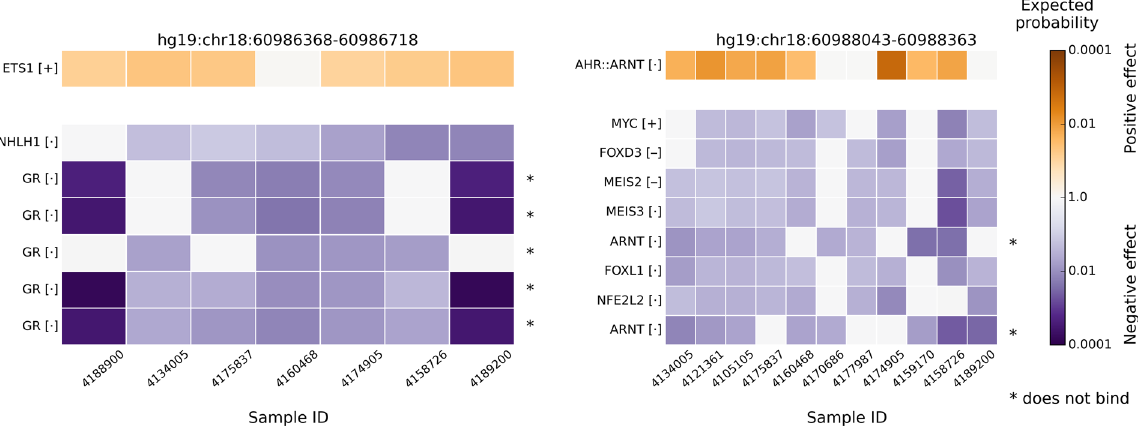
Figure 5. TFs significantly affected at BCL2 patient-specific regulatory mutation blocks. The row labels are the TF names, and the column labels are patients with a regulatory mutation block near the BCL2 TSS: block one (left) and block two (right). TF names are repeating when several alternative PWMs for a single TF are significantly affected. The color encodes the expected probability that the TF will be affected by random mutations as strongly as by the patient mutations, on the logarithmic scale. The positive and negative affinity changes are colored orange and blue, respectively. In square brackets inside row labels: “ + ” means that the TF is highly expressed in patient samples (top 25%), “ • ” means average expression, “ − ” means low expression (lower 25%). TFs with very low expression (RPKM < 0.03) were filtered out. Only TFs with significant changes (P < 0.05 after Bonferroni correction) across all patients are